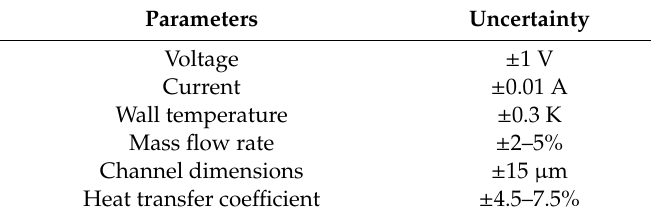
Table 1. Uncertainties in the experimental